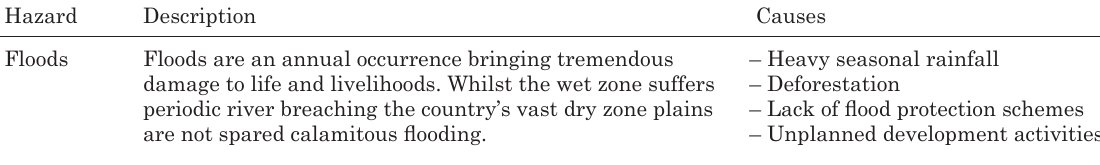
rivers originate from the central hills and flow table 1. frequent disaster types in sri lanka (adopted from: duryog nivaran, 2009) hazard description causes